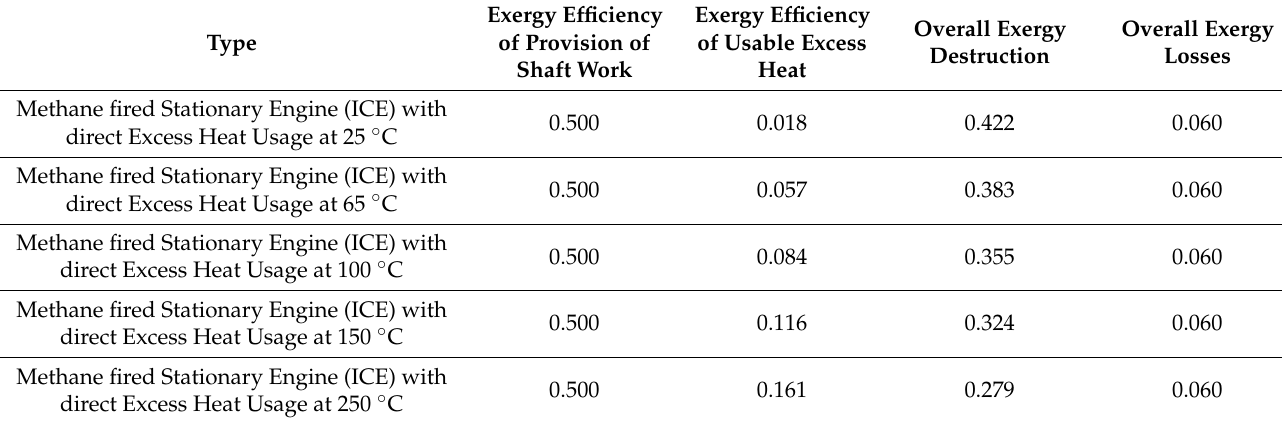
Table A8. Available conversion units for covering both, heat and shaft work demand of the scenario Energy Efficiency